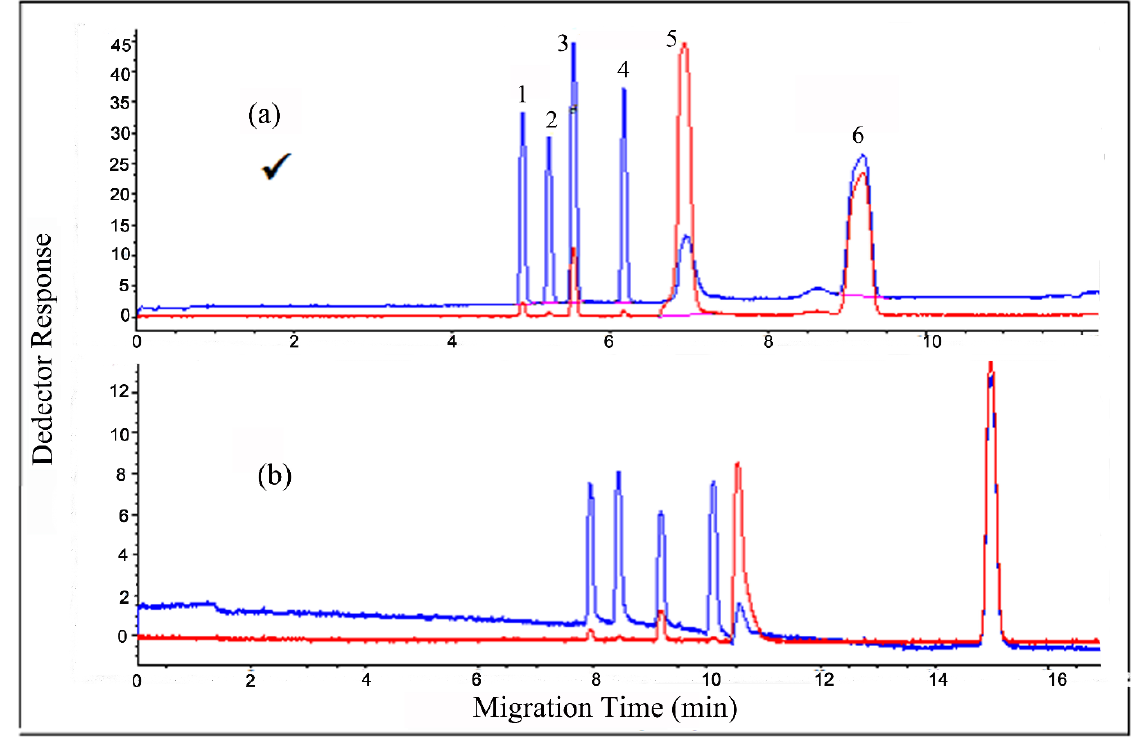
Figure S2 - Effect of capillary diameter on analysis λ=214 nm (blue line), λ=257 nm (red line), Capillary diameters: a)75 μm b)50 μm, Conditions: Hydrodynamic injection P =50 mbar, Separation Voltage=30 kV, T: 20ºC, BGE: 75 mmol L -1 Sodium borate inj (pH: 8.0) buffer-15% ACN, Peaks: 1)DEX 2)EPH 3)CHL 4)PSE 5)4-AP